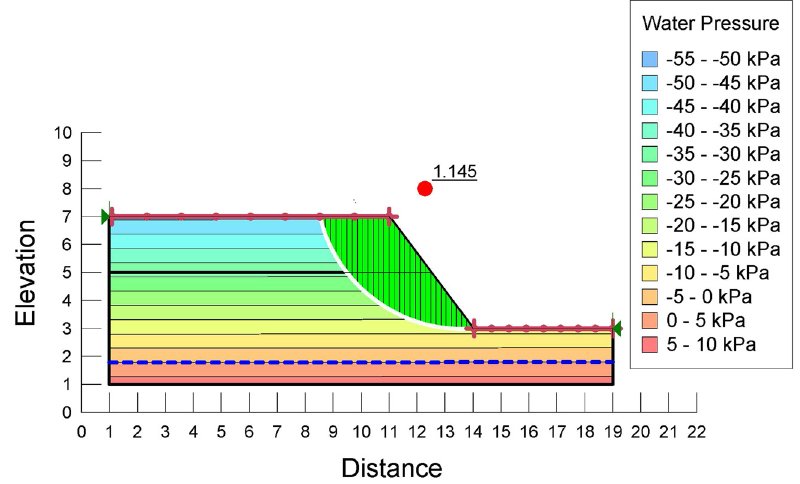
Figure 10: Slope stability for two cycles of applying rationing system.